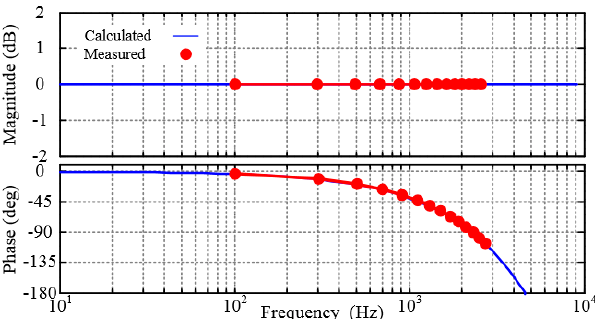
Figure 26. The measured and the calculated frequency response of the deadbeat current controller.